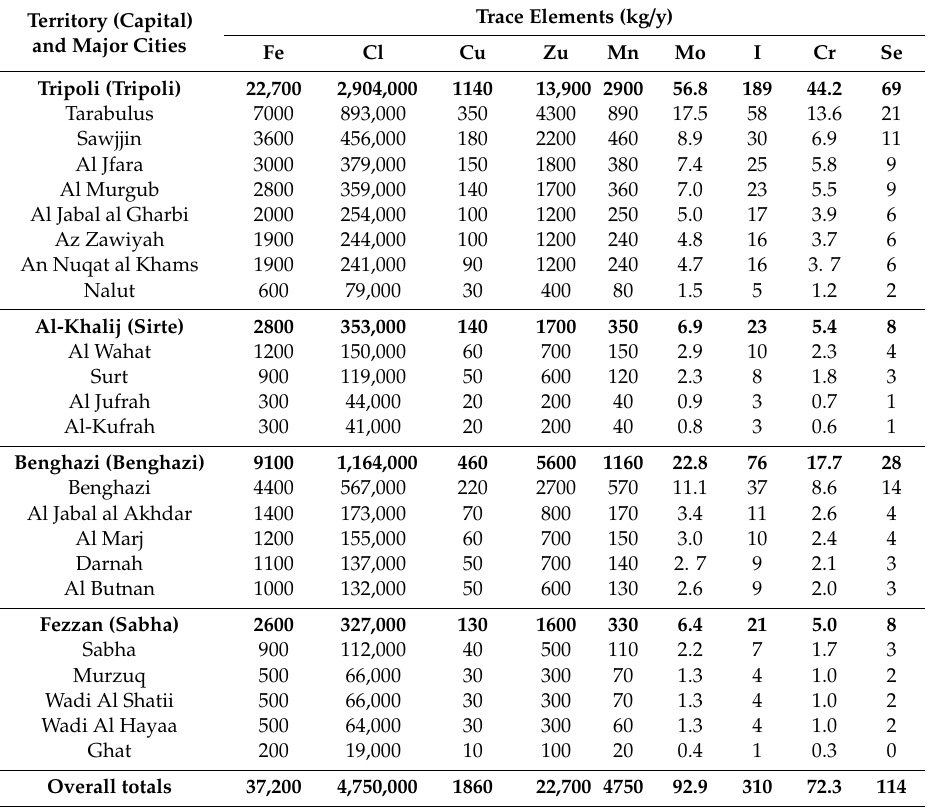
Table 12. The yearly recommended dietary allowances and adequate intakes of the trace elements based on the population report [13] for each of the Libyan territories and the capital and major cities